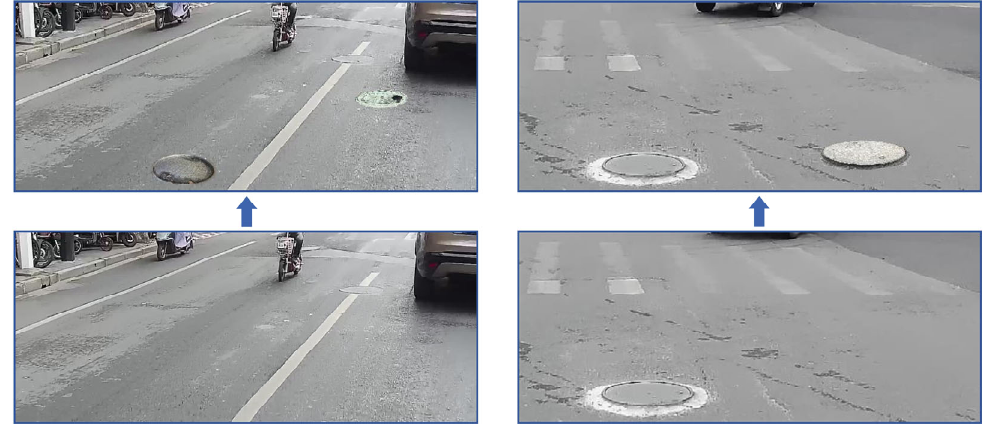
Figure 6. Examples of VGCopy ‐ paste. Table 2. Classification of manhole covers and the quantity of various covers collected.